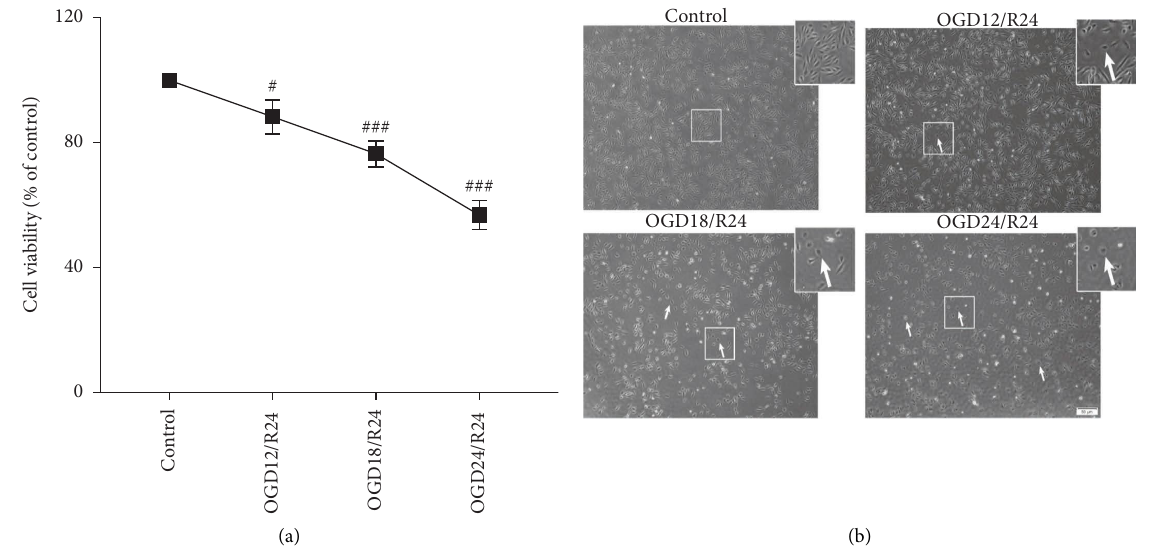
Figure 1: Diferent durations of oxygen and glucose deprivation have diverse efects on ARPE19 cell viability and morphology. (a) Cell viability was determined by a cell counting kit-8 assay. Te results are expressed as proportions of surviving cells compared with the control ( n � 5 per group). (b) Morphological changes in ARPE19 cells were observed by inverted microscopy. White arrows indicate severely shrunken and round cells ( n � 3 per group). Data are presented as means ± SEM, and group diferences were analyzed by Student’s t -tests. # P < 0 . 05, ### P < 0 . 001 vs. Control. Scale bar � 50 μ